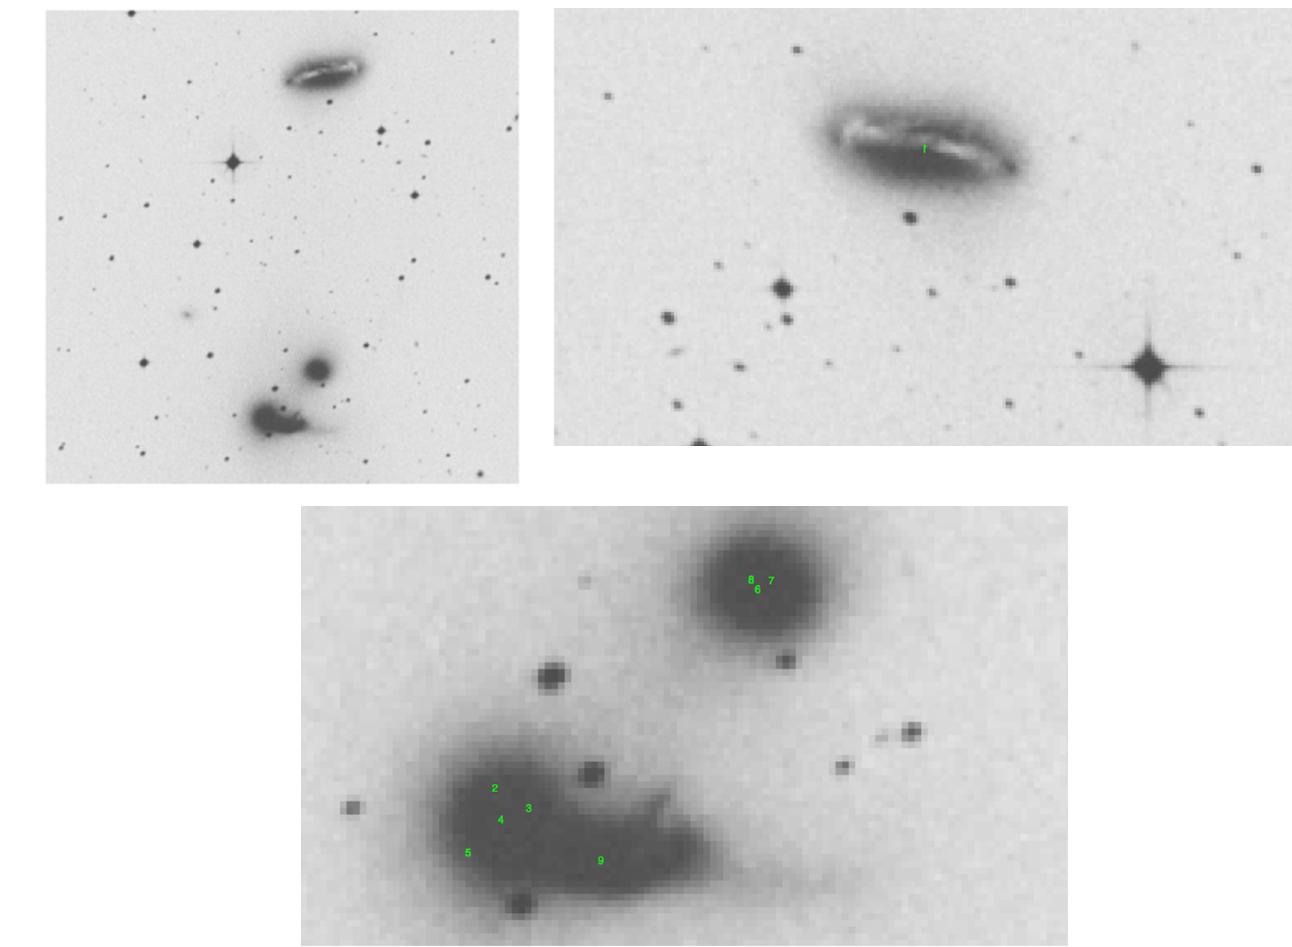
Figure 4. DSS image of HCG 90 ( top left ). X-ray point sources in NGC 7172 ( top right ). X-ray point sources in NGC 7176/NGC 7174 ( lower left—bottom image ) and NGC 7173 ( upper right—bottom image ).